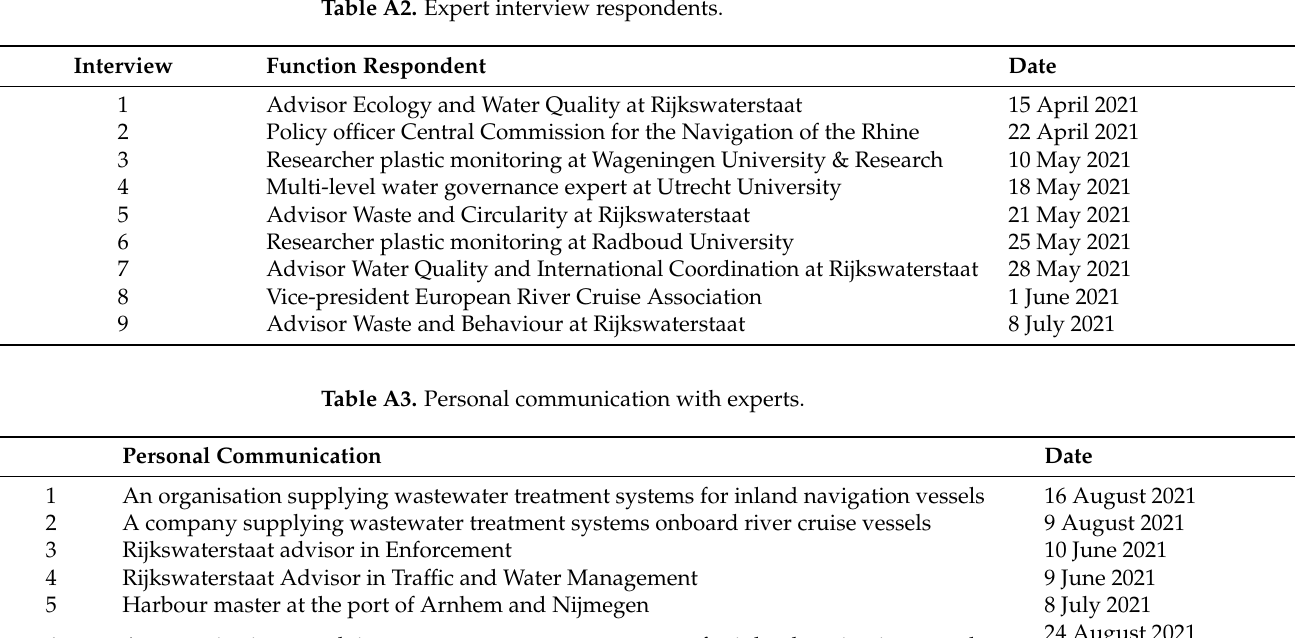
Table A2. Expert interview respondents.